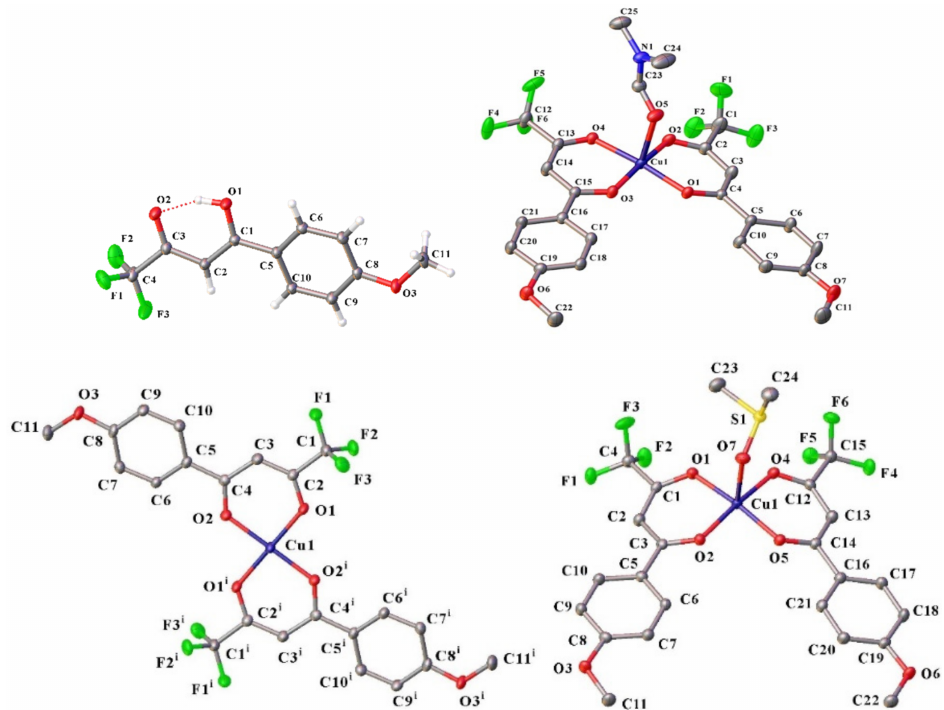
Figure 1. Molecular structures of the ligand H L1 (with partial atom labeling schemes) and complexes 1–3 . Displacement ellipsoids are at the 50% (for H L1 , 2 and 3 ) and 20% (for 1 ) prob- ability levels. The intramolecular hydrogen interaction in H L1 (O1–H · · · O2 1.63(2) Å) is represented as a dotted red line. Only molecule A is shown for complex 2 . For the sake of clarity, in 1 – 3, hydrogen atoms and minor positions of disordered groups are